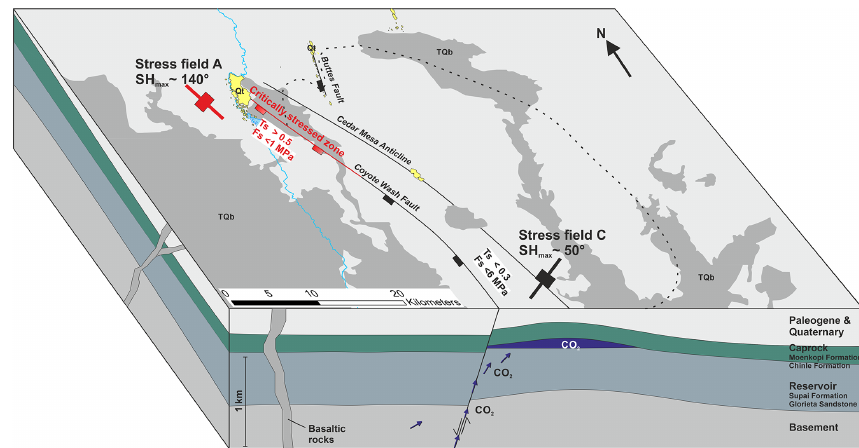
Figure 9. Block diagram illustrating the geological setting of the St. Johns Dome area. The fault-bound CO 2 reservoir has been filled with CO 2 from depth, and leakage of CO 2 from the reservoir to the surface occurs at the NW tip of the Coyote Wash Fault. The leakage is geomechanically controlled as the stress field orientation changes along the strike of the fault as well as the strike direction of the fault. At the NW tip of the fault slip, stability values of > 0 . 5 and fracture stability of less than 1MPa indicate a critically stressed fault. See Fig. 2 for a complete legend, ∼ 10 × vertical